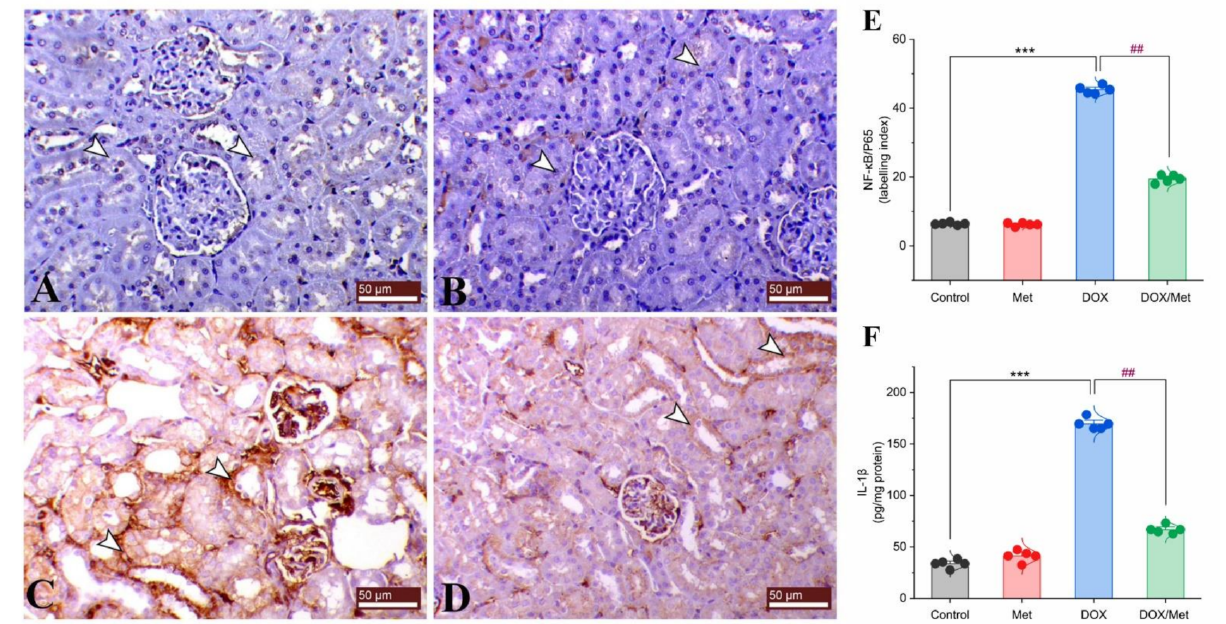
Figure 6. Prophylactic effect of Met on DOX-induced inflammation. The figure shows the protein expression of NF- κ B/P65 by immunostaining in control ( A ), Met ( B ), DOX ( C ), and DOX/Met ( D ) groups (arrows indicate the positive stained area; bars = 50 µ m). ( E ) Bar-dot plot of the semi- quantitative analysis of NF- κ B/P65 expression levels in renal tissue obtained by immunostaining. ( F ) Bar-dot plot of the renal concentration of IL-1 β after Met and/or DOX treatments. Student’s t -test was used for statistical comparisons. Data are expressed as mean ± SEM. Colored dots indicate each individual value and colored curves represent the distribution of each data point. *** p < 0.001 vs. control group and ## p < 0.01 vs. DOX